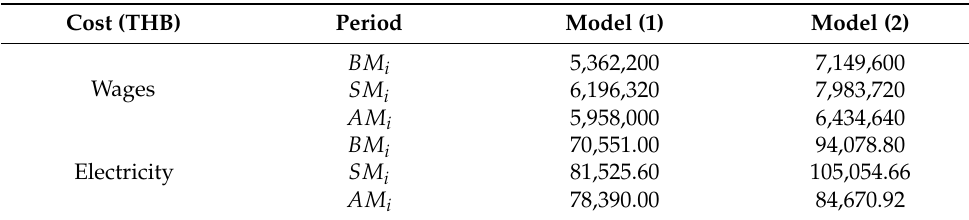
Table 16. Comparison of costs for Model (1) and Model (2). Cost (THB) Period Model